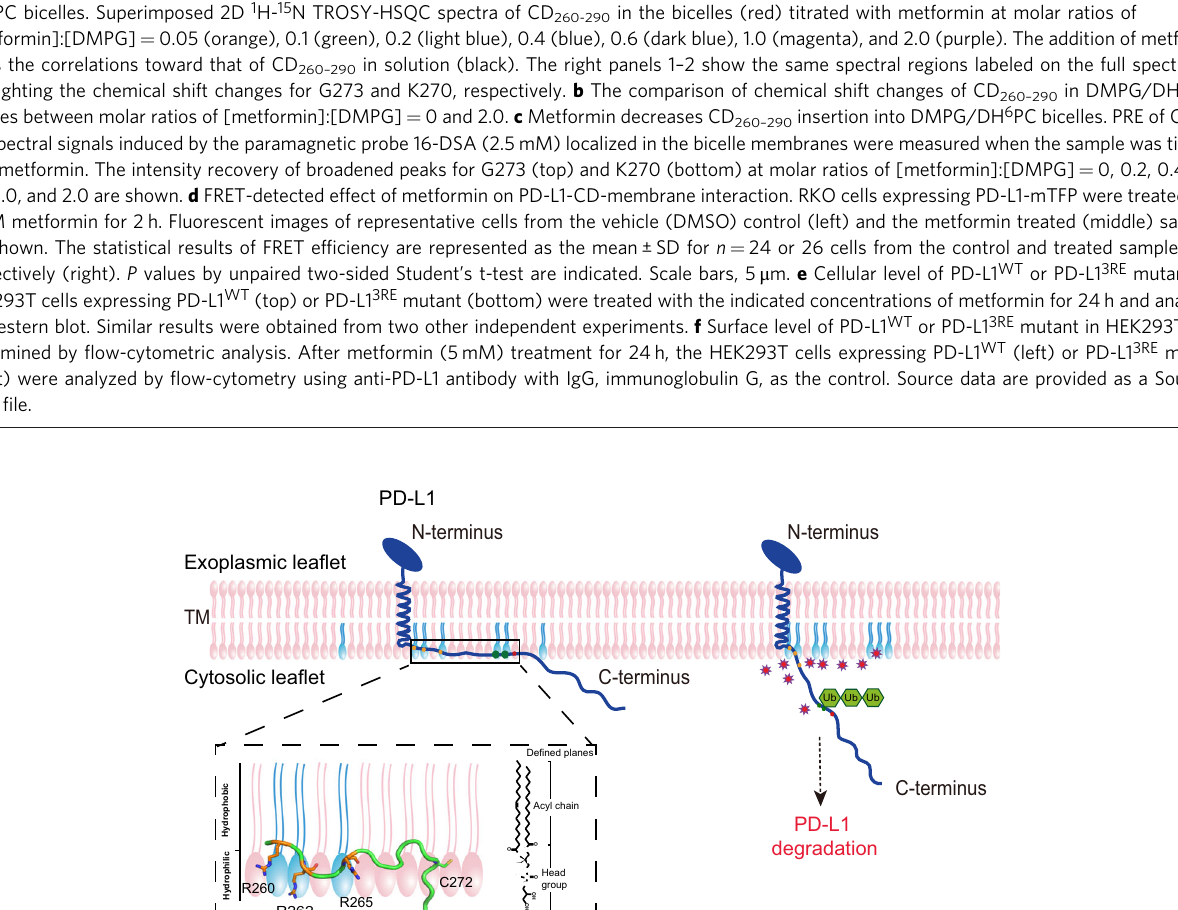
Fig. 5 Metformin prevents PD-L1-CD-membrane association to induce PD-L1 degradation. a Metformin reduces CD 260-290 interaction with DMPG/ DH 6 PC bicelles. Superimposed 2D 1 H- 15 N TROSY-HSQC spectra of CD 260-290 in the bicelles (red) titrated with metformin at molar ratios of